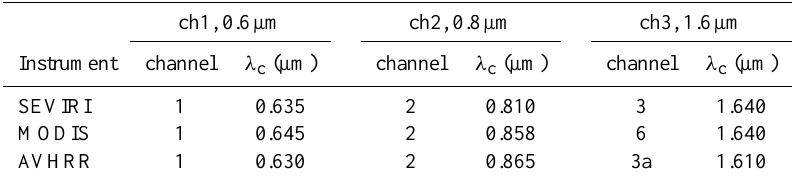
Table 1. Channel numbers and central wavelengths λ c of the solar channels considered in this study together with the approximate wave- lengths used for